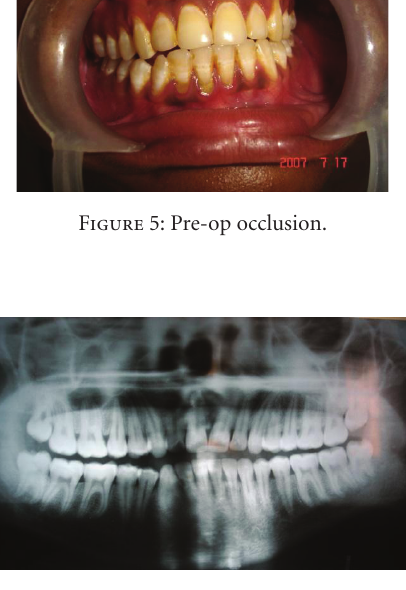
Figure 6: Pre-op